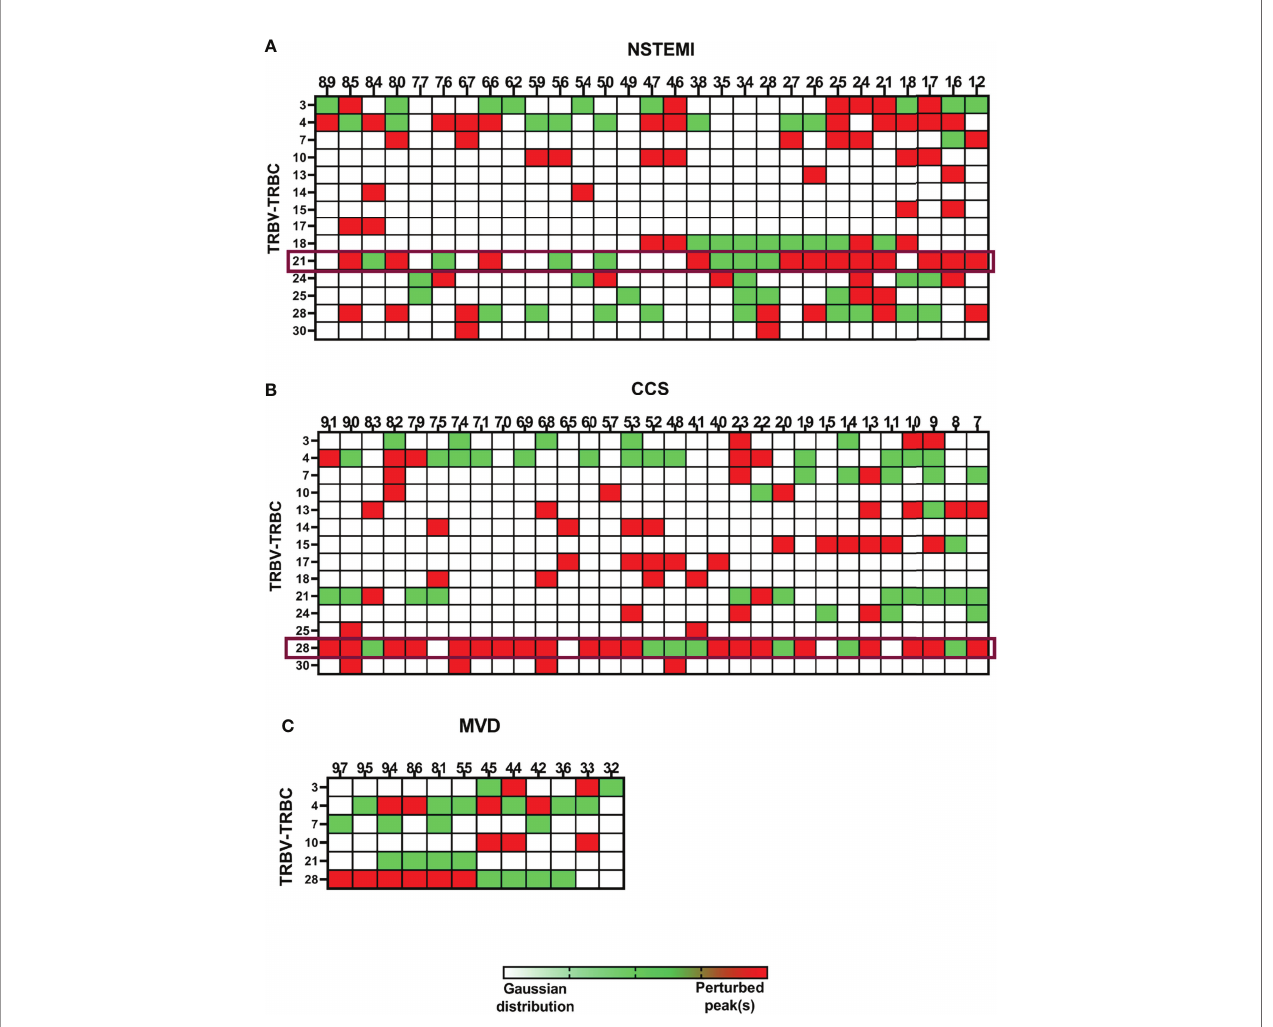
FIGURE 3 | Quantitative analysis of TCR repertoire perturbations. The TRBV-TRBC spectratyping technique was applied to analyze the TCR repertoires of the enrolled patients. EAT samples were compared with the respective PBMCs. Three matrixes are displayed, one for each group of patients [ (A) for NSTEMI, (B) for CCS, and (C) for MVD]. Single patients are displayed in columns, while the rows represent the same TRBV-TRBC TCR recombination for all patients in each group. Each square of the matrixes represents a TRBV-TRBC rearrangement for every single patient. TRBV-TRBC spectratypes from an ideal naive TCR repertoire follow an approximate Gaussian distribution containing eight or more peaks. Skewed TRBV-TRBC pro fi les can be detected as perturbation of this distribution. White squares represent non-perturbed Gaussian. Green squares display minimally perturbed Gaussian. Red squares indicate a high enrichment of the same peak(s) in the EAT sample compared with the homologous PBMC sample. Despite the high variability of the TCR repertoire used by each individual, it was possible to detect speci fi c TCR signatures characterizing NSTEMI, CCS, or MVD